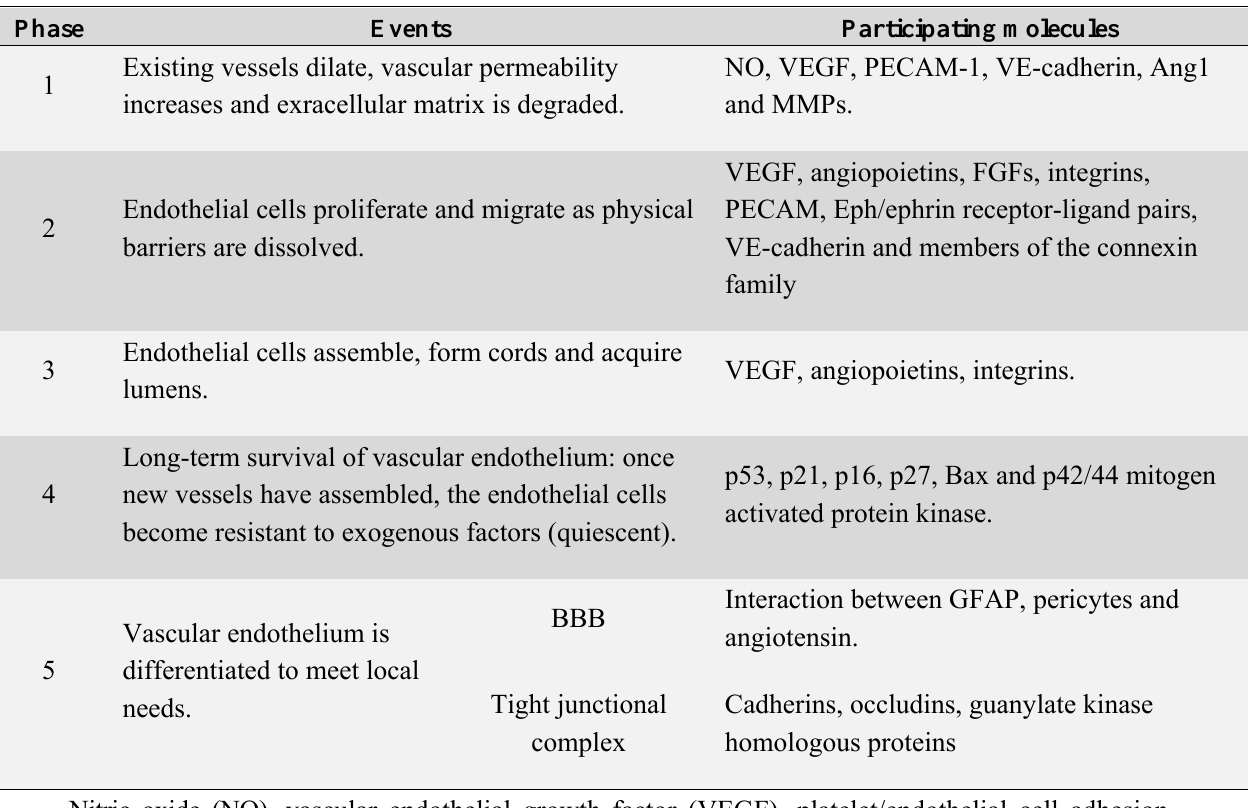
Table 1. The events occurring in different phases of angiogenesis and the participating